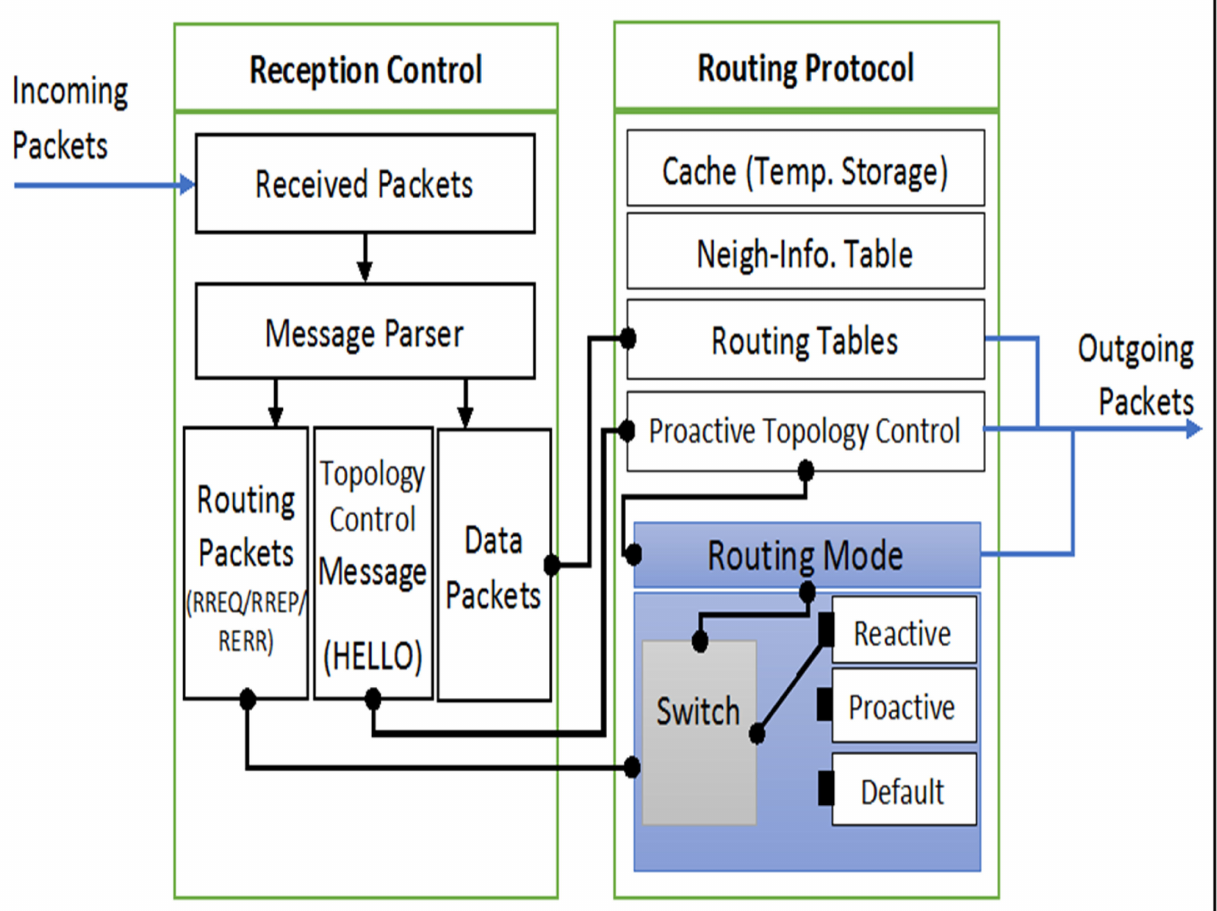
Figure 7. Smart node’s